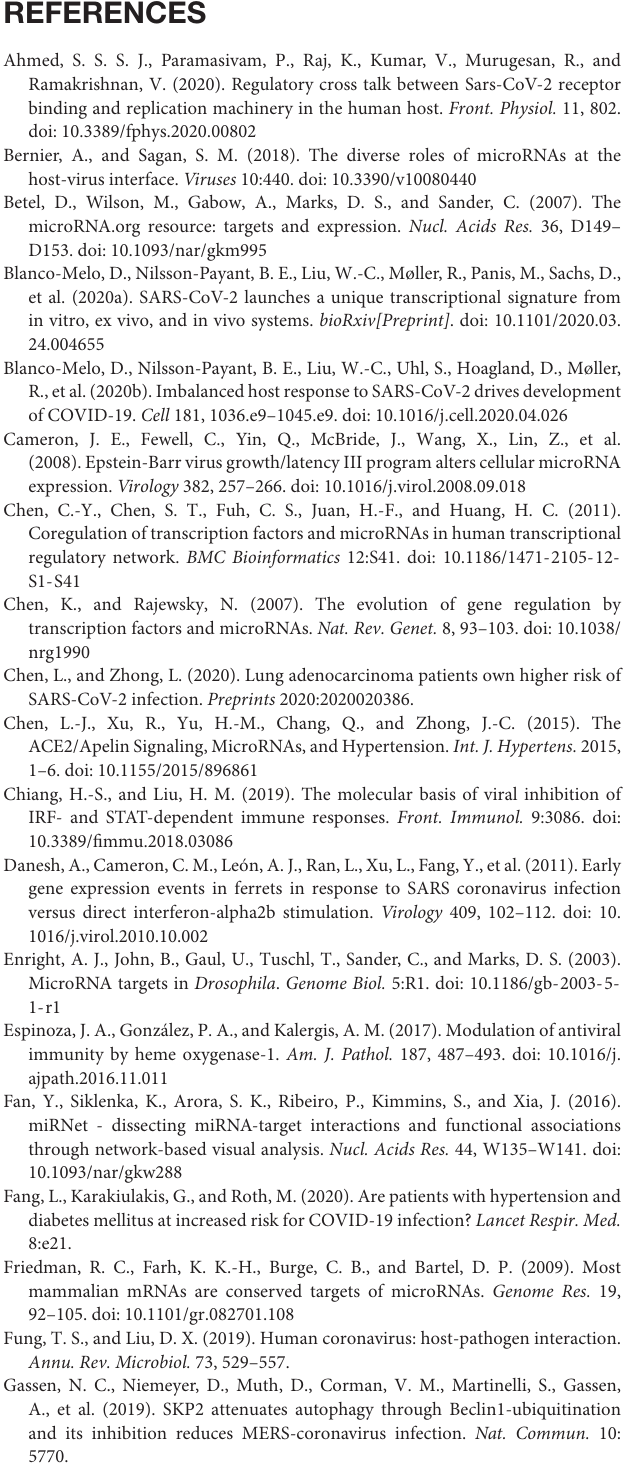
TABLE S7| miRNA identification inSARS-CoV, influenza, and measles from miRtarP. TABLE S8 | miRNA–TF interaction analysis in respiratory